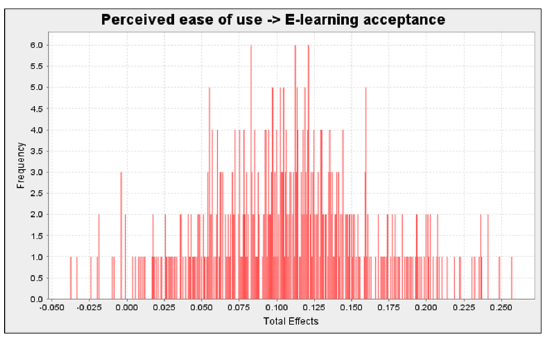
Fig. 3. The impact of self-efficacy of the students on the be- havioral intention to adopt e-learning